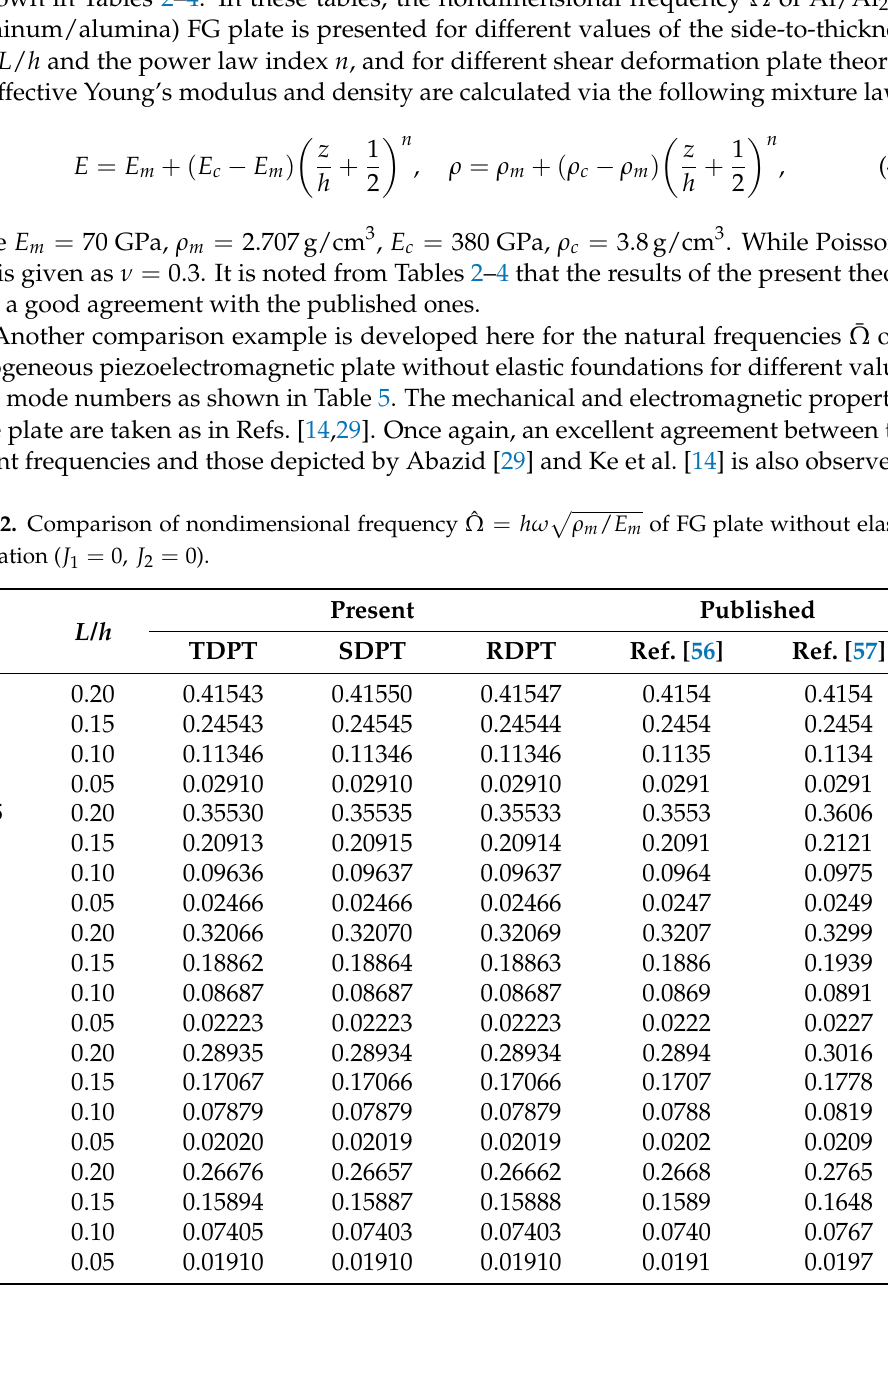
(cid:112) ρ m / E m of FG plate without elastic